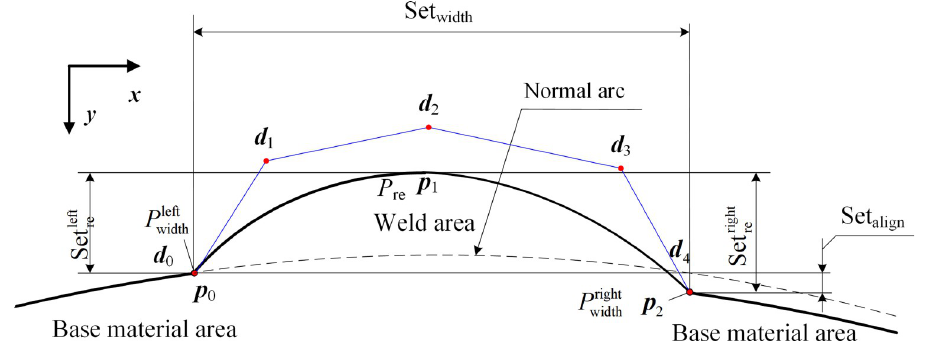
Fig 11. Simulation of weld profile curve with single defect parameter misalignment Set align .